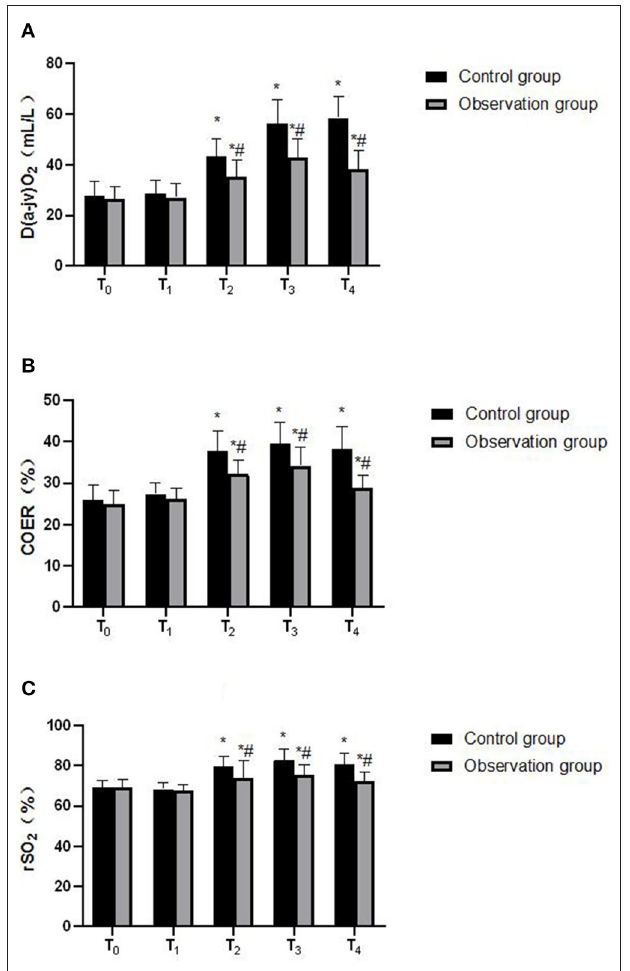
FIGURE 1 | Comparison of D(a-jv)O2, COER%, rSO2 at different time points between the two groups. (A) D(a-jv)O2; (B) COER% and (C) rSO2. Compared with T 0 in the samegroup, * P < 0.05; compared with control group, # P < 0.05.